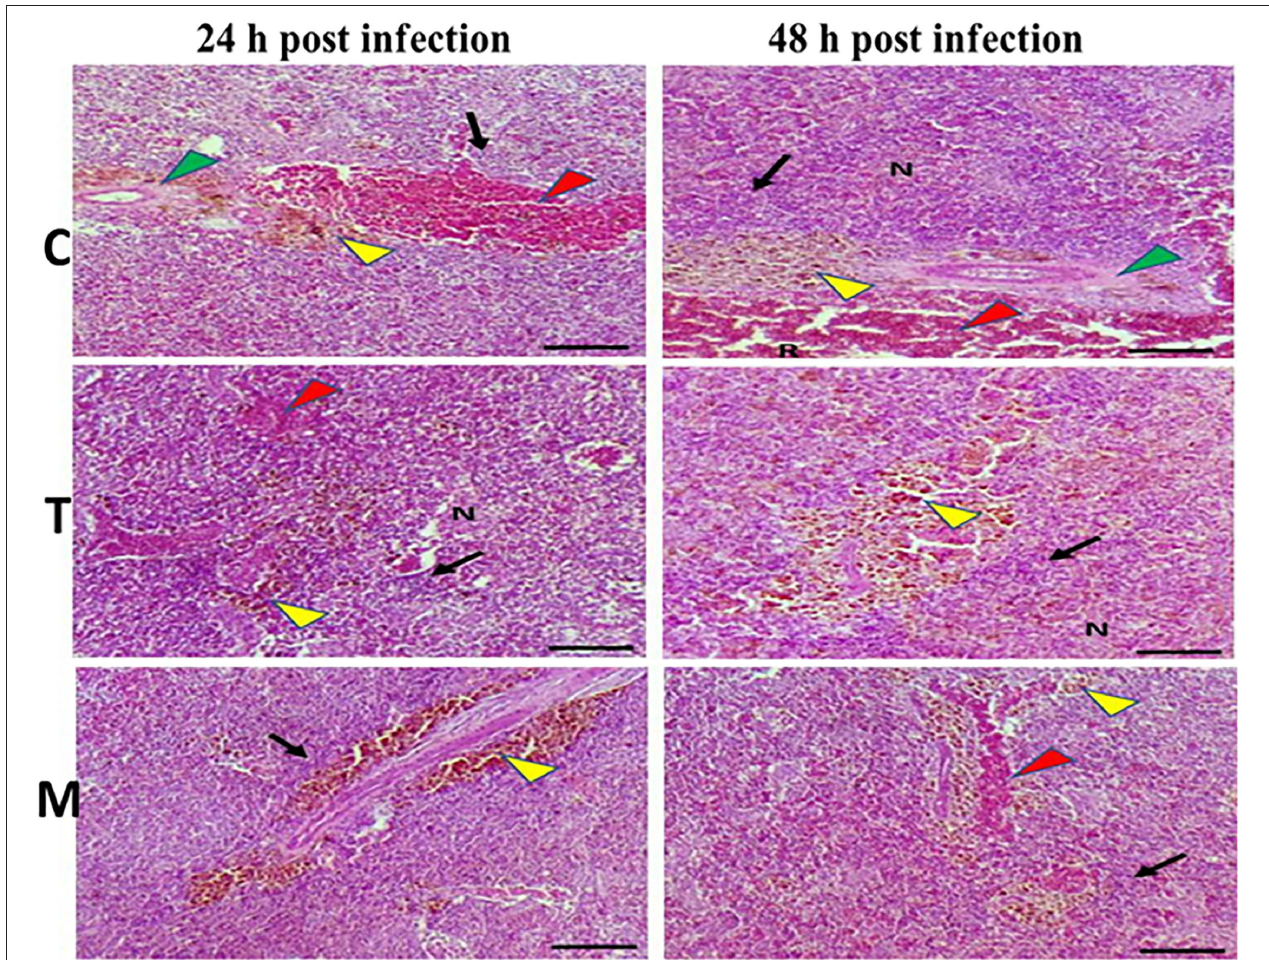
FIGURE 7 | H&E stained histomicrograph of spleen of tilapia following 24 and 48h of A. hydrophila infection with and without moringa dietary inclusion. C, T, and M denote the 0, 5, and 10% moringa levels, respectively. R, red pulp; W, white pulp; N, necrosis; red arrowhead (congestion), yellow arrowhead (Melanomacrophage center), green arrowhead (perivascular edema), black arrow (lymphocytic